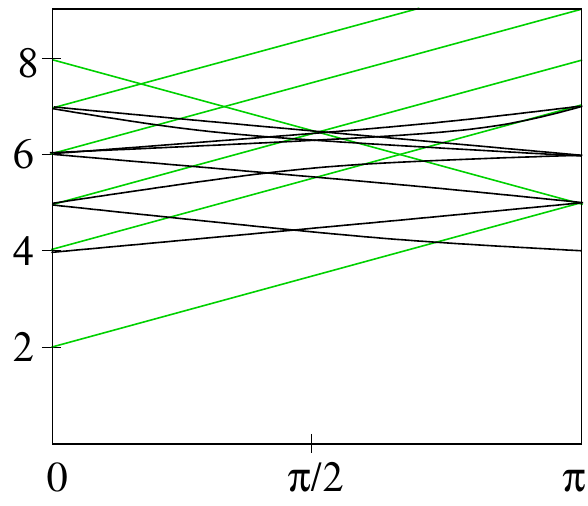
Figure 1: Spectrum of low-lying states for n = 3 anyons with repulsive interactions, computed numerically. Based on the results of [ 13 ]